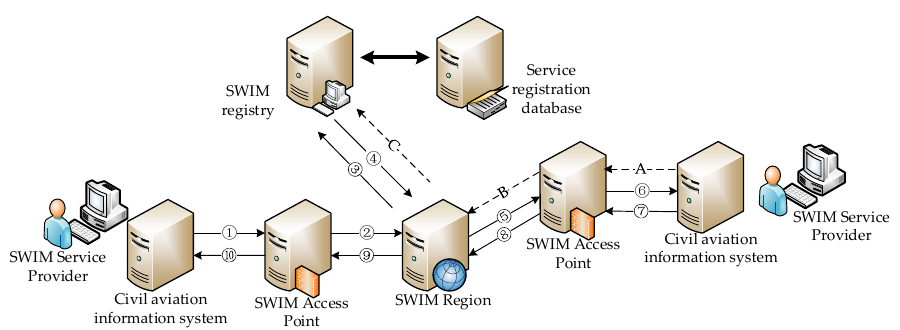
Figure 2. The system-wide information management (SWIM) service information interaction process.